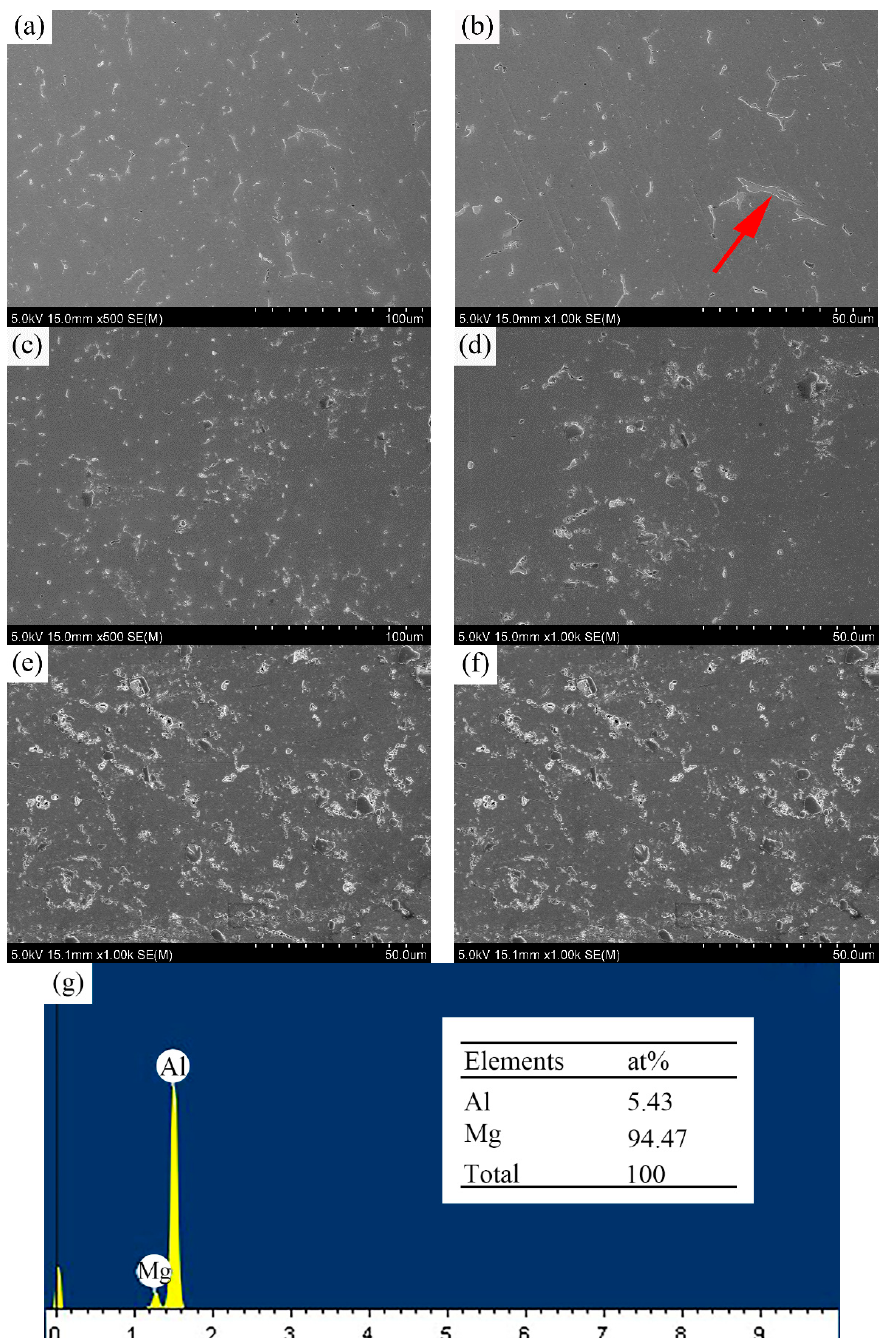
Figure 5. SEM images of weld joints with composites fillers containing ( a ) and ( b ) 0 wt% TiC particles; ( d ) and ( c ) 2 wt% TiC particles; ( e ) and ( f ) 4 wt% TiC particles and ( g ) corresponding EDS point analysis taken from the arrowed second phases in (b).